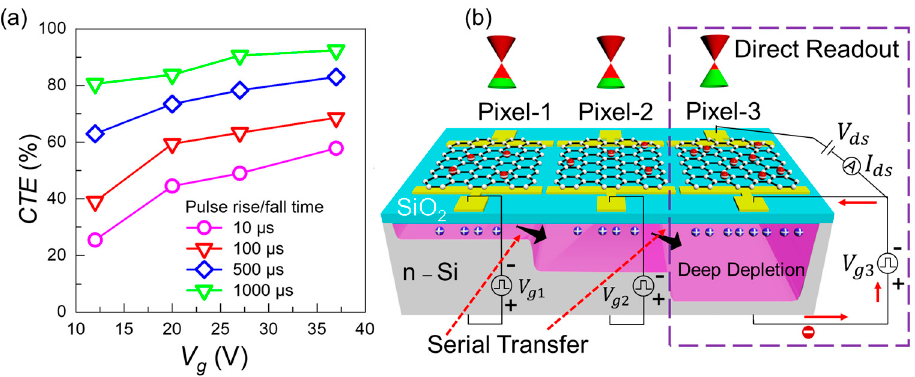
Figure 5. ( a ) CTE is plotted vs. phase amplitude at various switching slopes. ( b ) The 3D schematic for a three adjacent Gr-Si CCD pixels platform is shown with related circuitry to implement serial transfer and random-access modes due to V g 1 , V g 2, and V g 3 clock phases. Photo charges will be held in the left well; after strong fringing field development by ramping up, the charge will be released by removing the central barrier, and graphene will read the enhanced charge density by recording I g in the avalanche or multiplication unit.